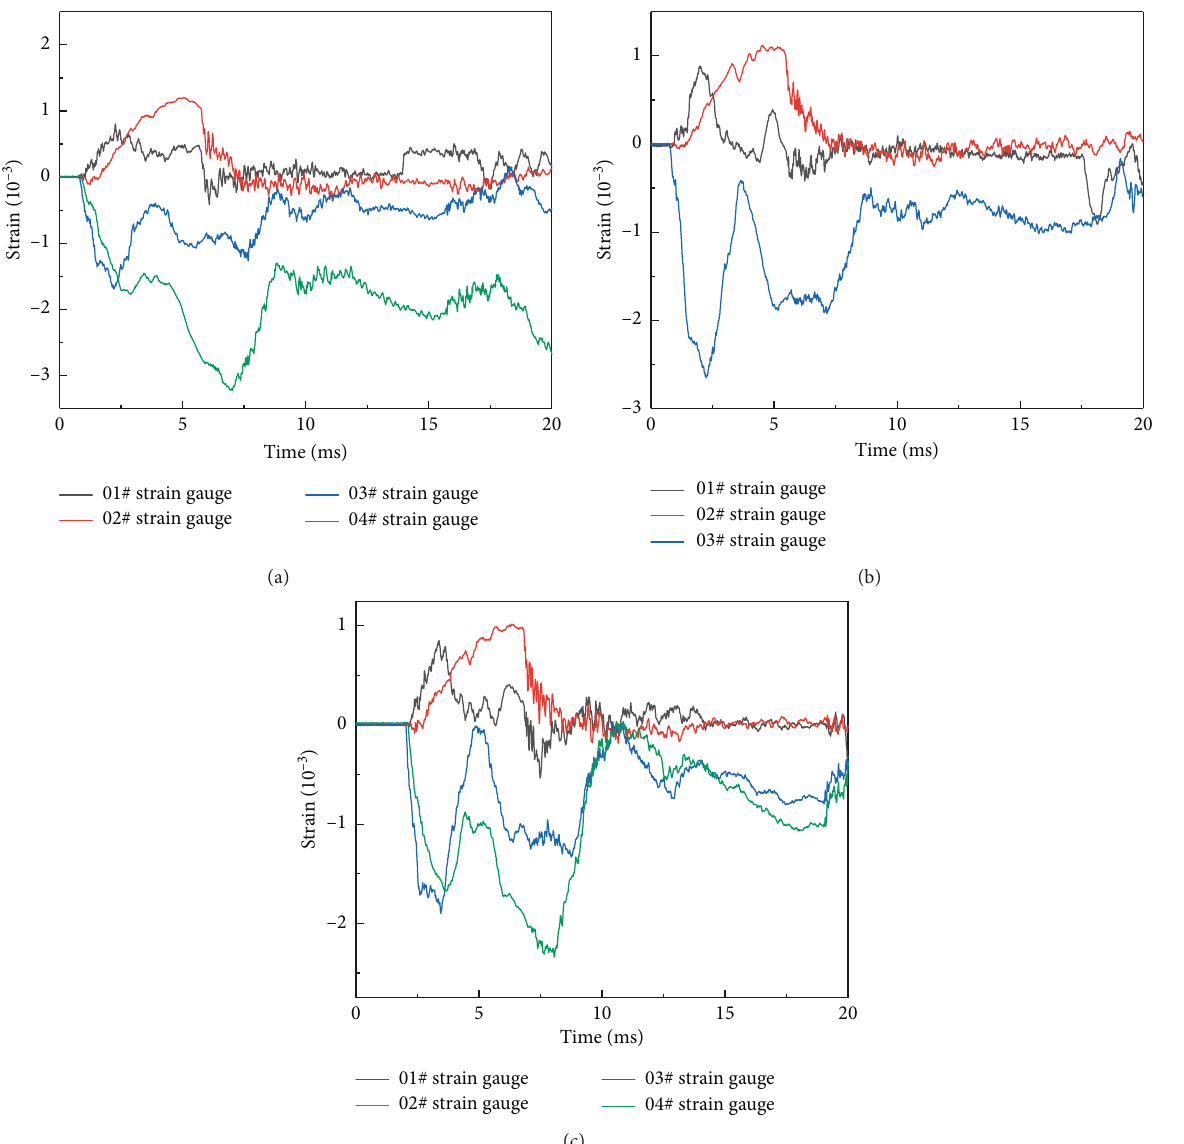
Figure 15: The strain response curves of the middle points on the outer surface of the column segment. (a) T-1, (b) T-2, and (c)